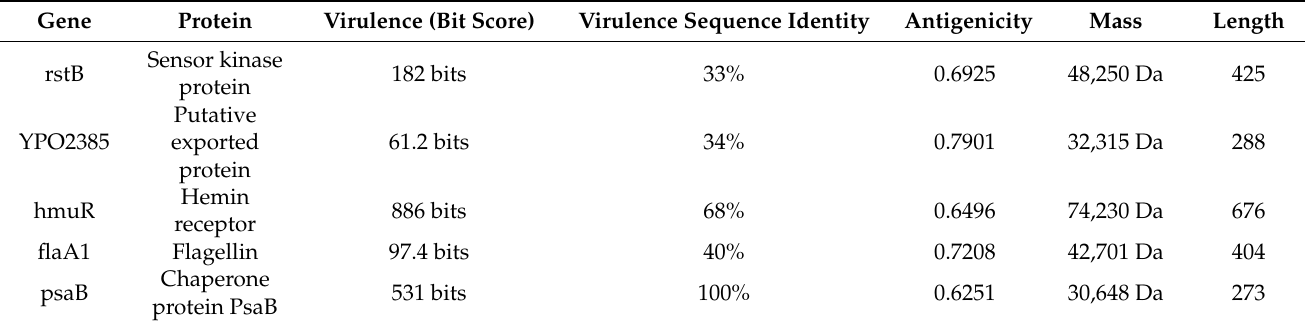
Table 1. The genes, protein names, antigenicity scores, virulence scores, molecular masses, and amino acid lengths of the five shortlisted vaccine targets.